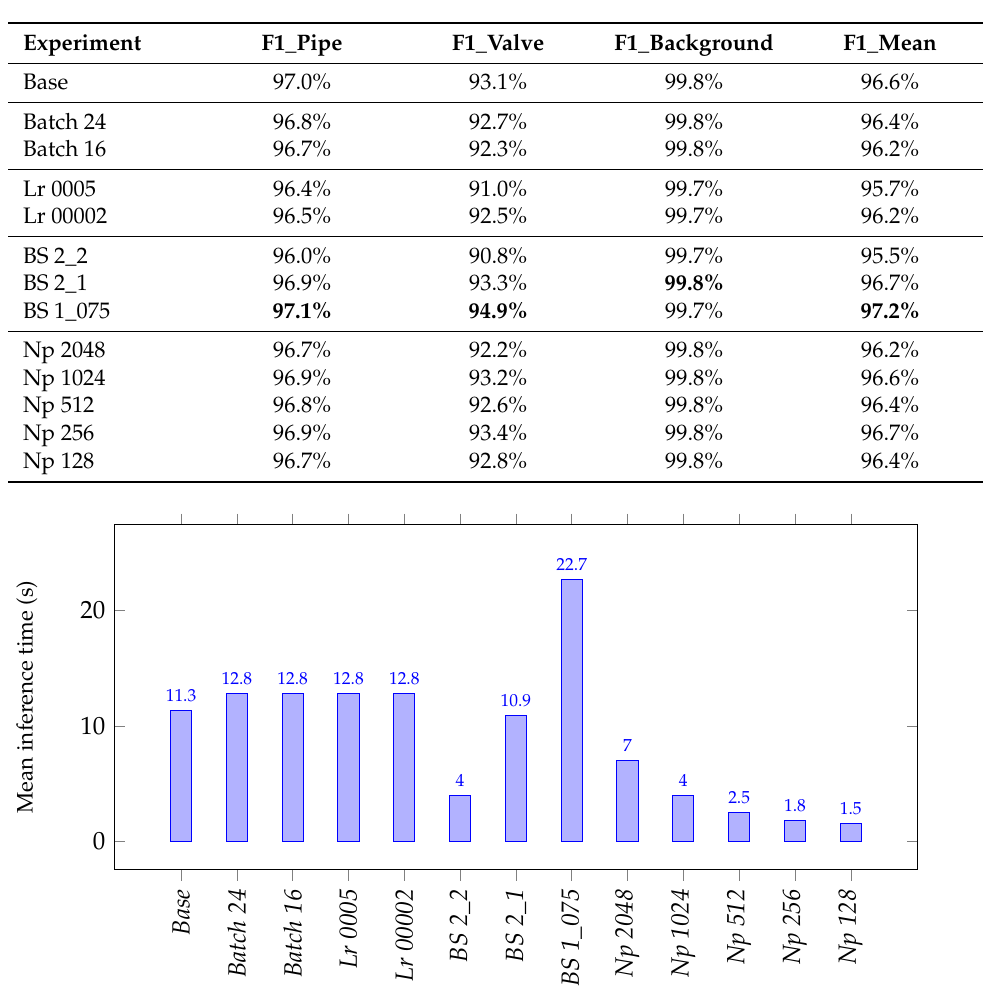
Table 2. Pool test set F1-scores .